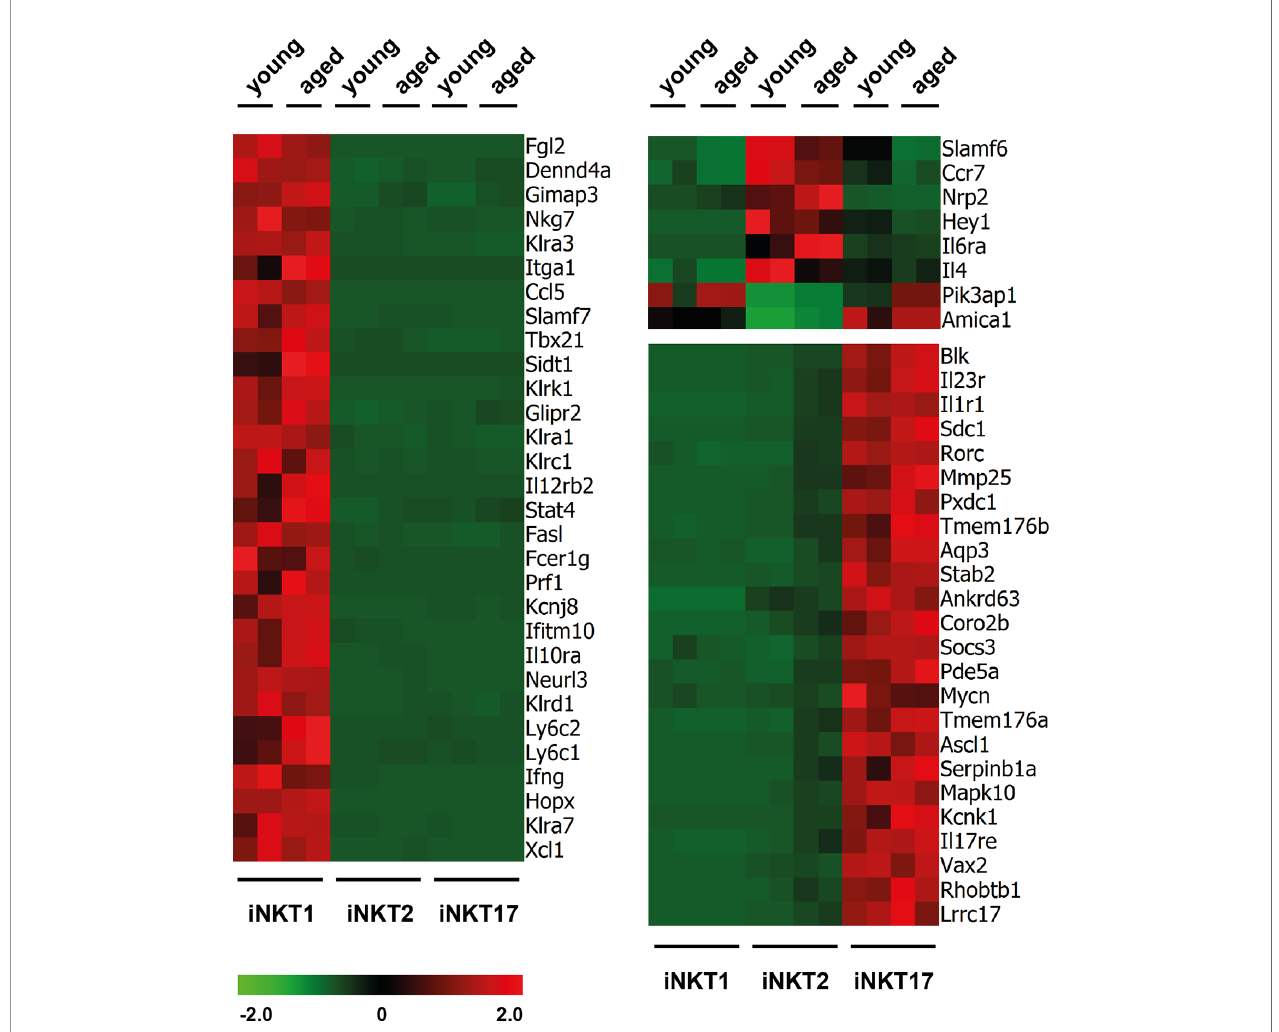
FIGURE 2 | Expression of signature genes in invariant natural killer T (iNKT) subsets from young adults and aged mice. Heat maps depicting genes upregulated (red) or downregulated (green) in thymic iNKT1, 2 and 17 cells from young adult or aged BALB/c mice. Data from two independent experiments are shown as described in the text and Materials and Methods